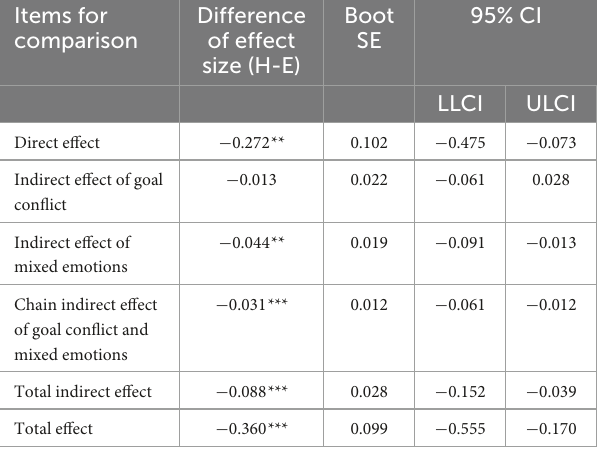
TABLE 3 Comparison of the effects of hedonic motivation and eudaimonic motivation on life satisfaction. Items for